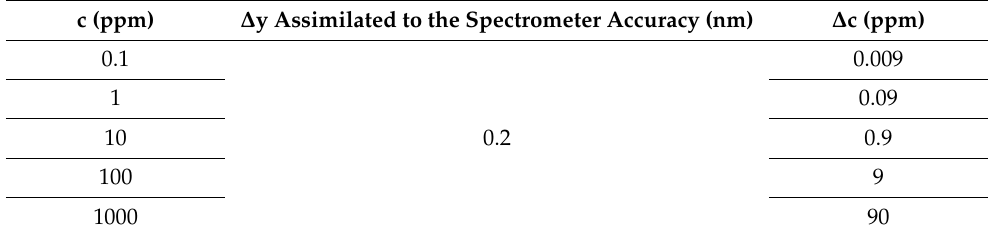
Table 3. Estimated errors on the gliadin content using the plasmon resonance maximum. c